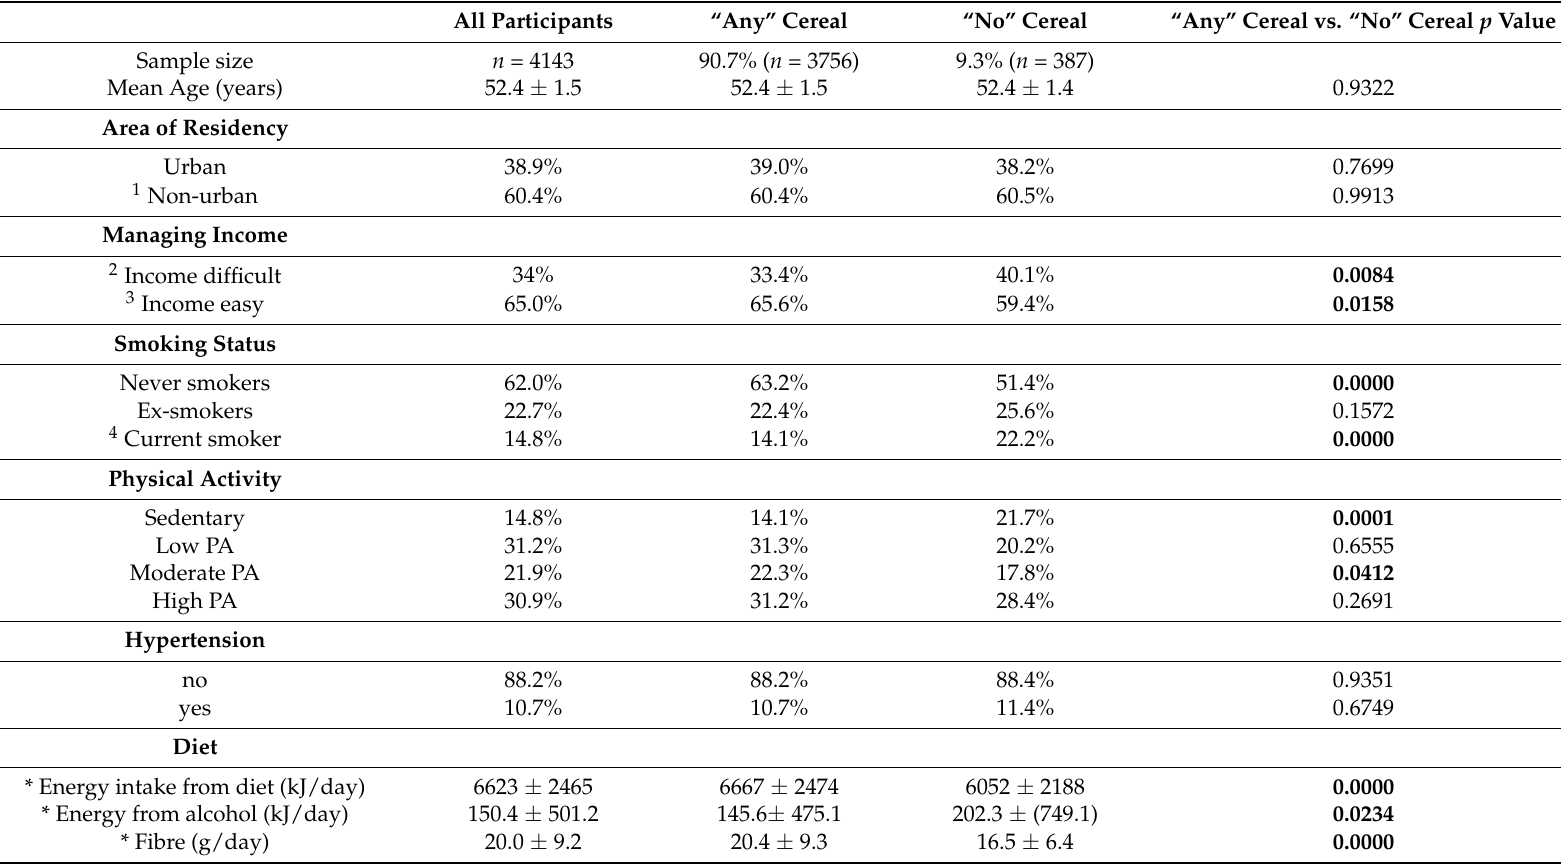
Table 1. Characteristics of participants from the mid-age (2001) cohort of the Australian Longitudinal Study on Women’s Health at Survey 3 ( n = 4143) by “any” breakfast cereal and ‘no’ breakfast cereal